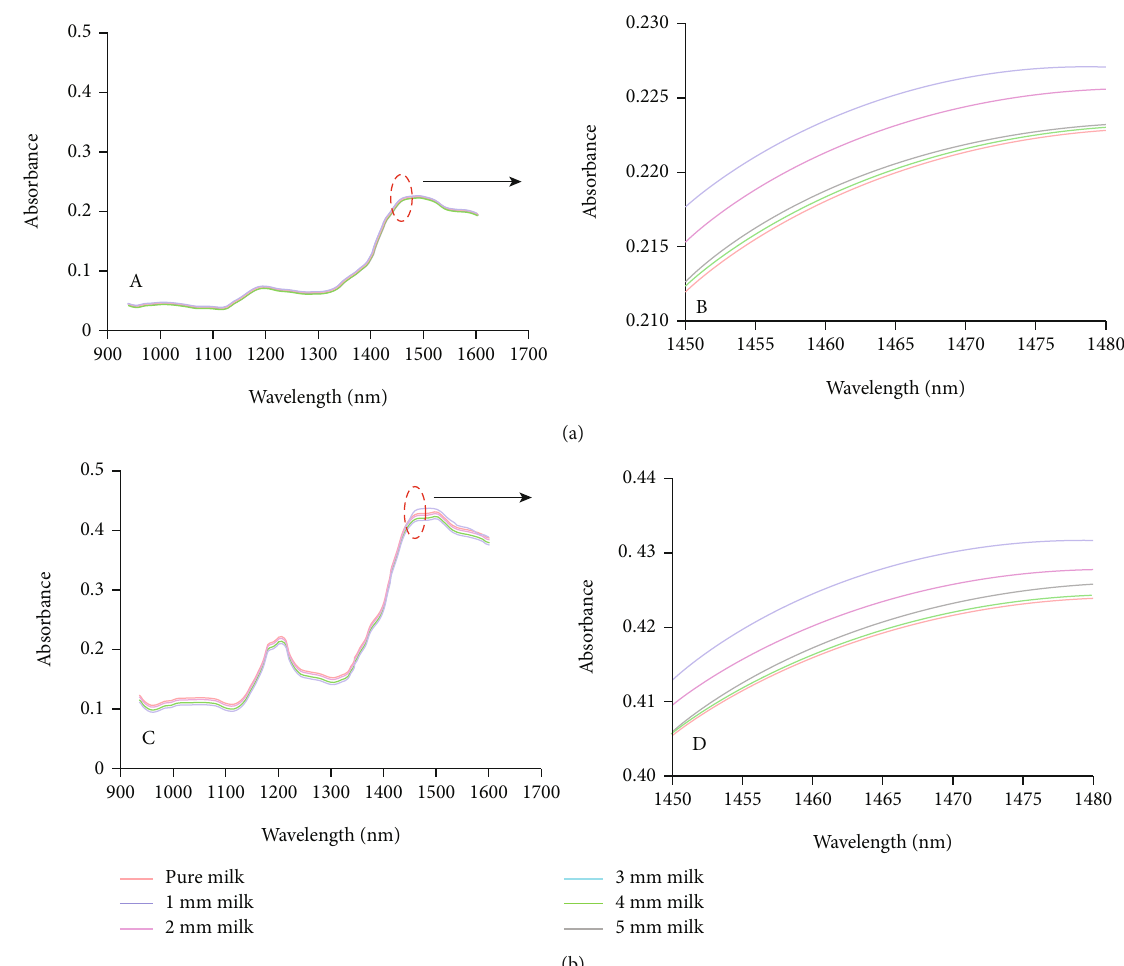
Figure 2: Raman spectra of milk powder and melamine measured using di ff erent penetration depth of milk samples prepared using “ valley ” nonfat milk (a) and “ peak ” whole milk (b). Plots A and C show the full spectra, while plots B and D show the enlarged spectra in the wavelength of 1466.3nm